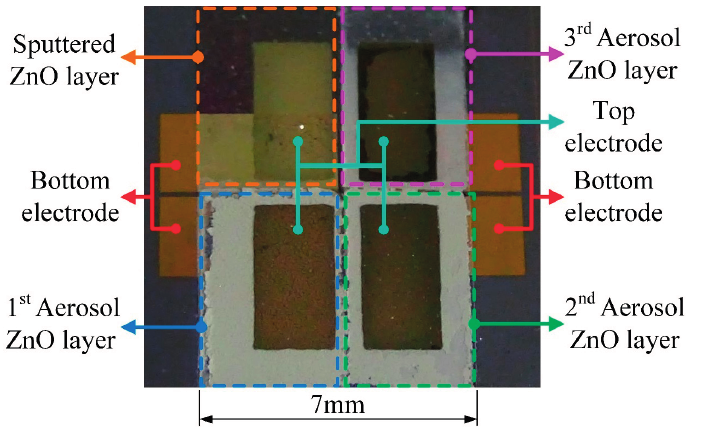
Figure 4. Fabricated multi-frequency band pyroelectric sensor with an improved